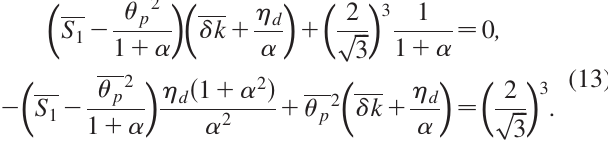
¼ 0 , (cid:5) ¼ 0 : 5 . (cid:3) d